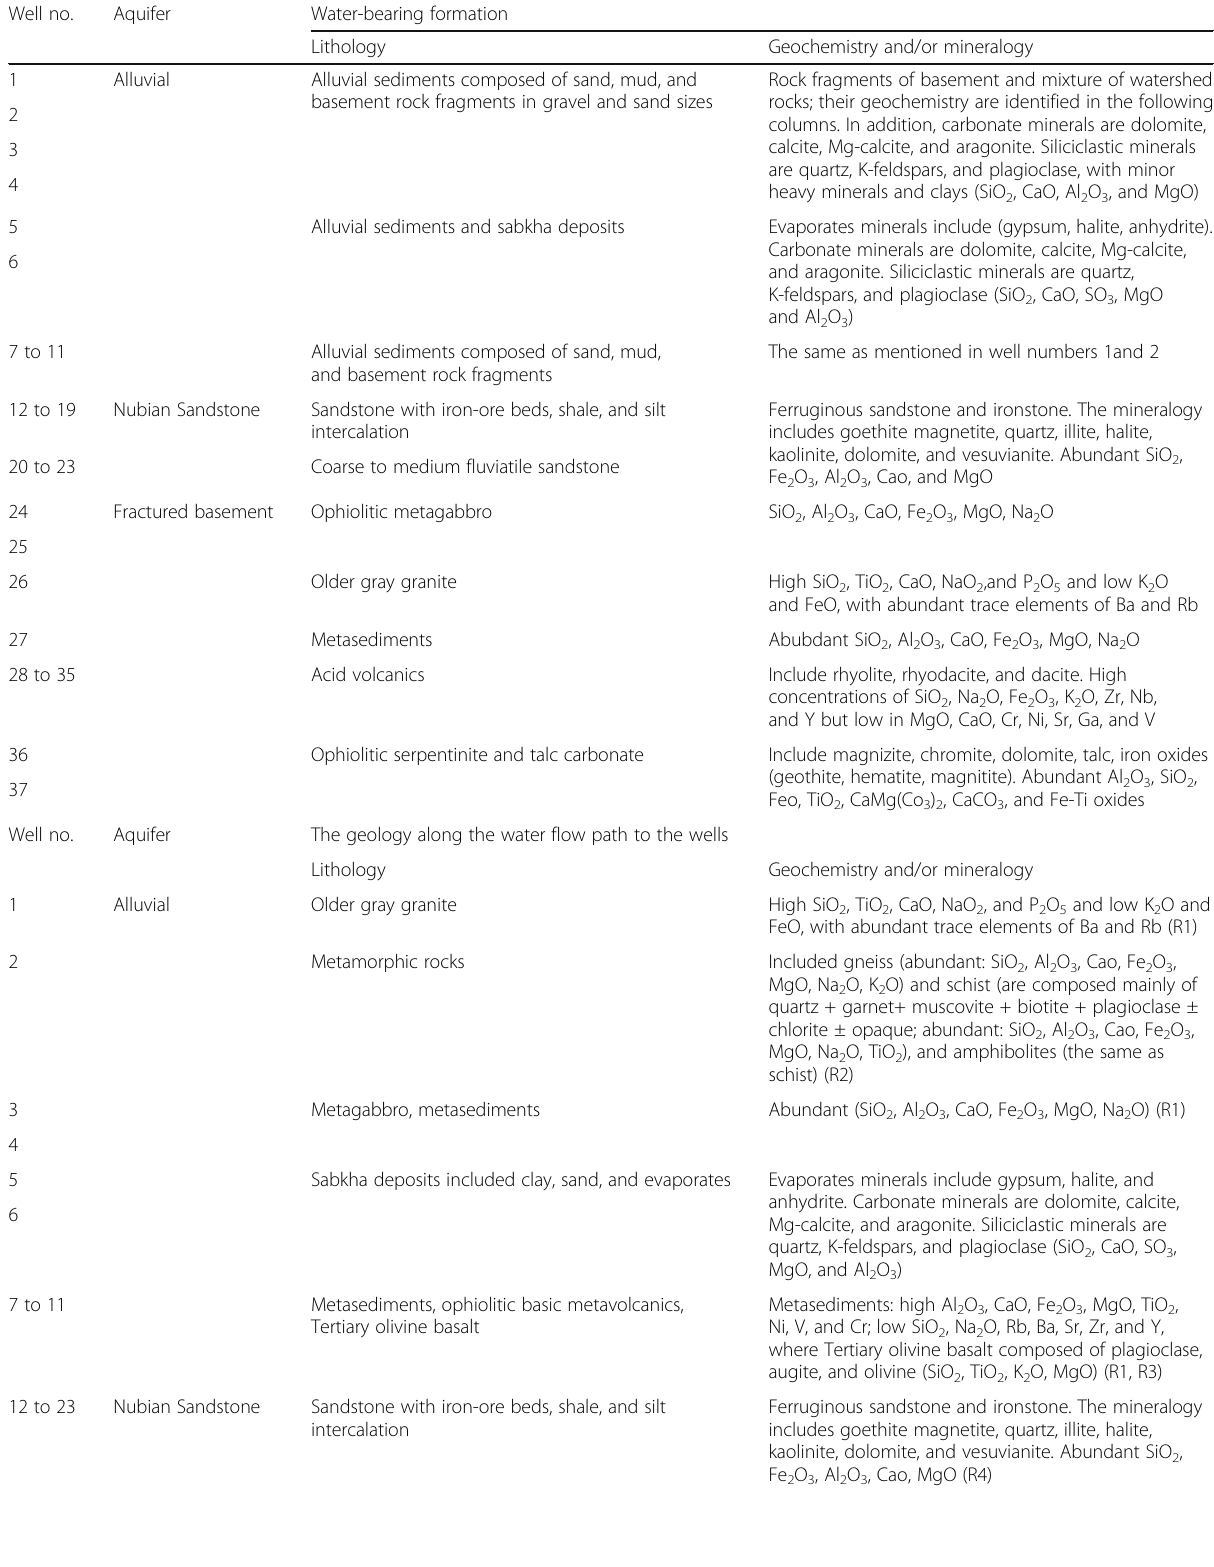
Table 5 Geology and geochemistry of water bearing formation and watershed affecting groundwater wells Well